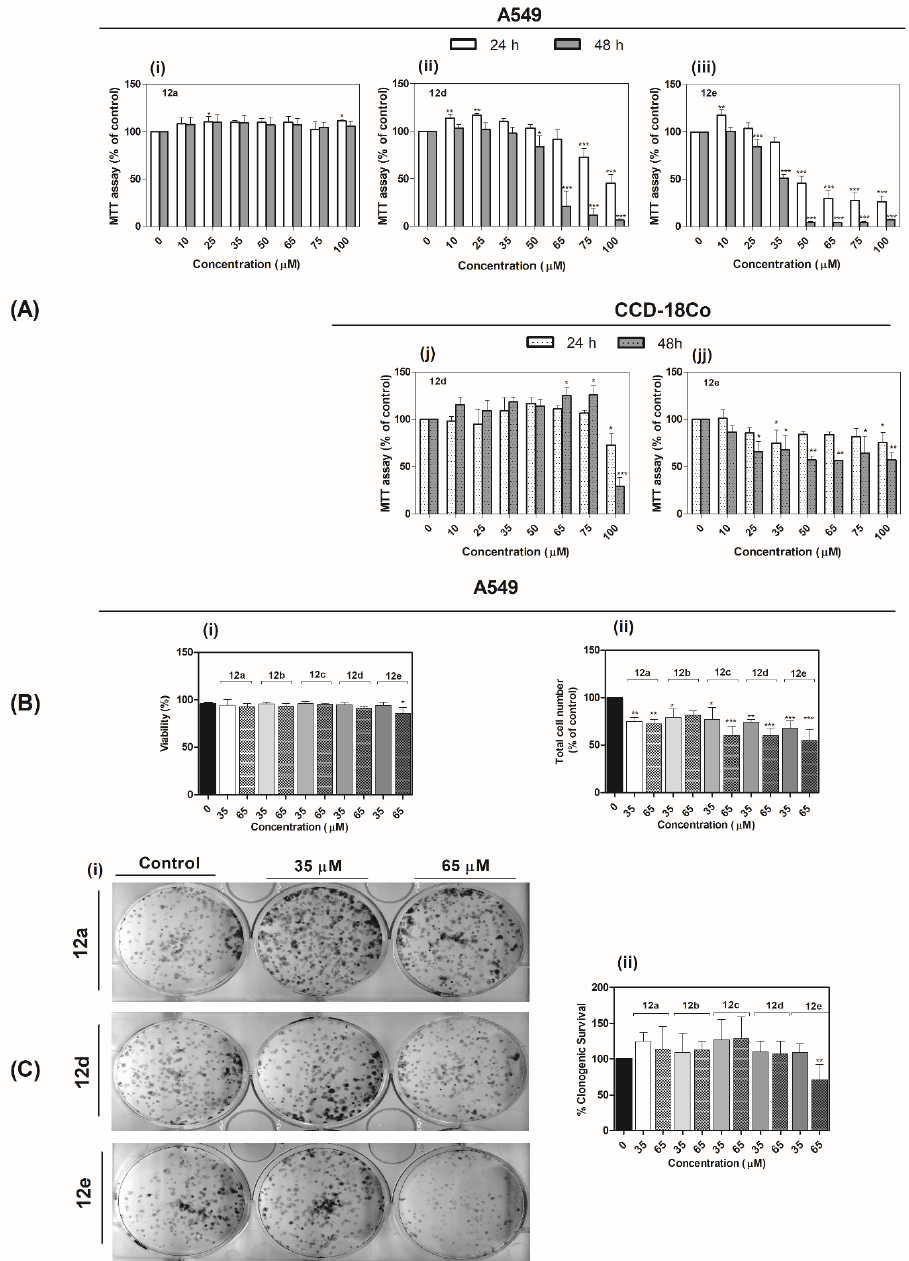
Figure 5. In vitro antiproliferative activity. ( A ): Effects of derivatives 12a (i), 12d (ii/j), and 12e (iii/jj) on A549/CCD-18Co cell line metabolic activity evaluated by MTT assay. The cells were treated with the indicated concentrations of the compounds for 24 and 48 h. Statistical significance * p < 0.05; ** p < 0.01; *** p < 0.001 for each experimental group compared to the untreated cells. ( B ): Effect of derivatives 12a – e on cell viability (i) and total cell number (ii) of A549 cell line. The viability and total cell number were evaluated 24 h after derivatives addition and are expressed as percentage of the viable, eosin negative cells or as a percentage of the total cell number of untreated control, respectively. Statistical significance * p < 0.05; ** p < 0.01; *** p < 0.001 for each experimental group compared to the untreated cells. ( C ): Effect of derivatives 12a – e on A549 cells’ ability to form colonies. (i) Representative image of colonies in both the presence and absence of compounds ( 12a , 12d , and 12e ) treatment. (ii) Data represent the percentage of colony-forming ability presented as the mean values ± S.D. of three independent experiments. Statistical significance (**): p < 0.01 for experimental group compared to the untreated